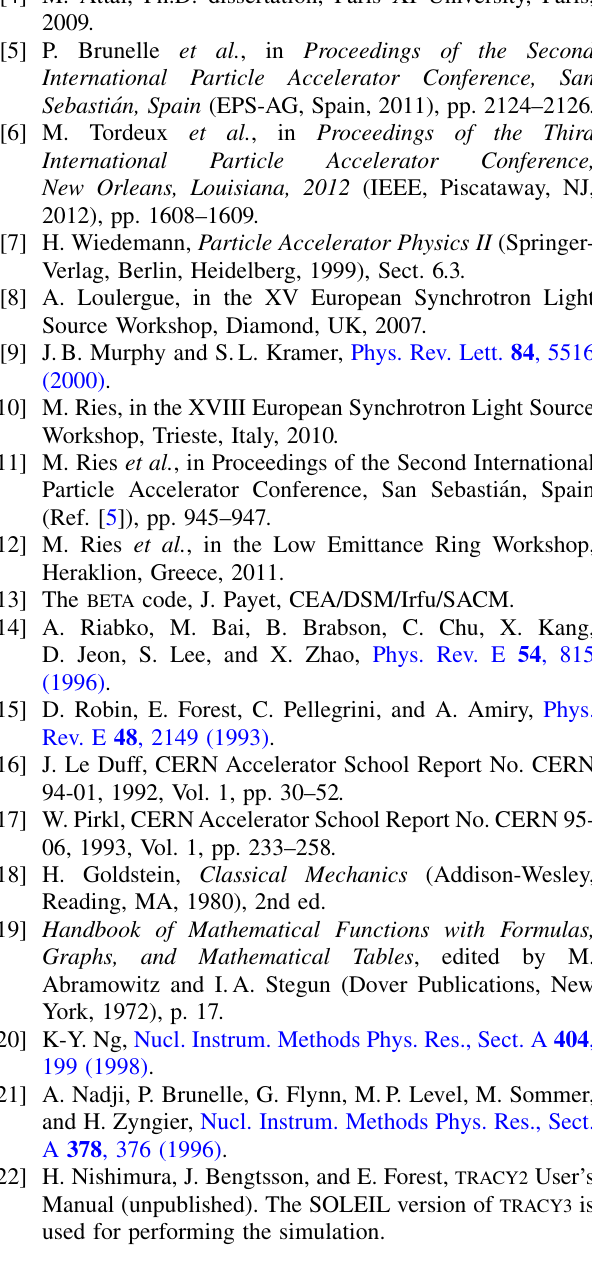
Manual (unpublished). The SOLEIL version of TRACY3 is used for performing the